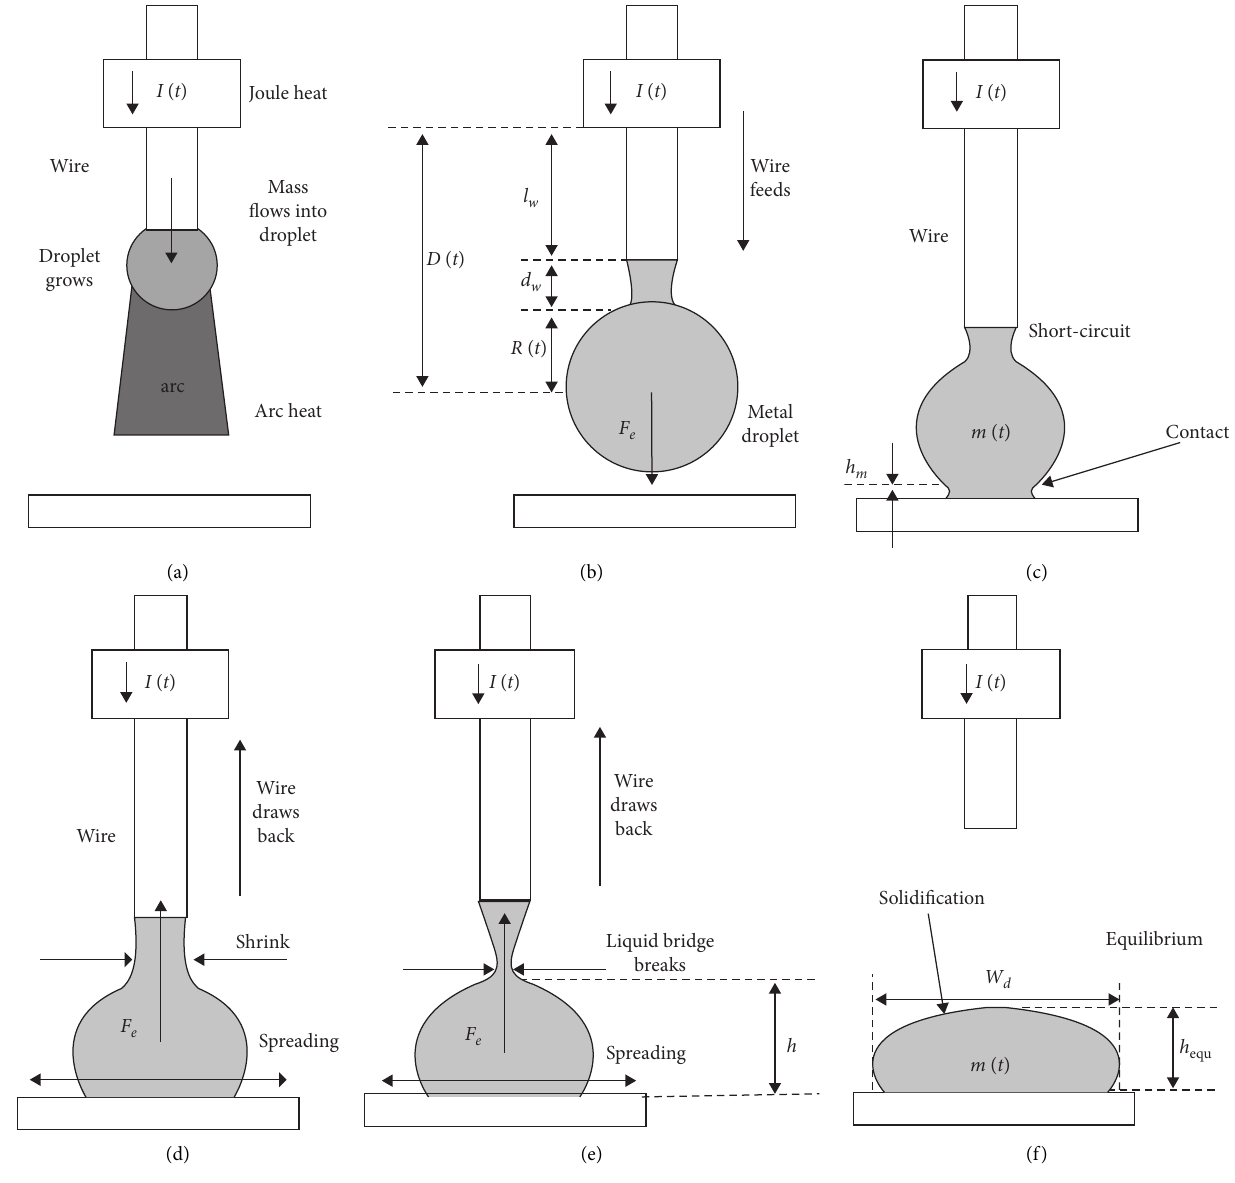
Figure 5: Short-circuit transfer model in cold metal transfer.